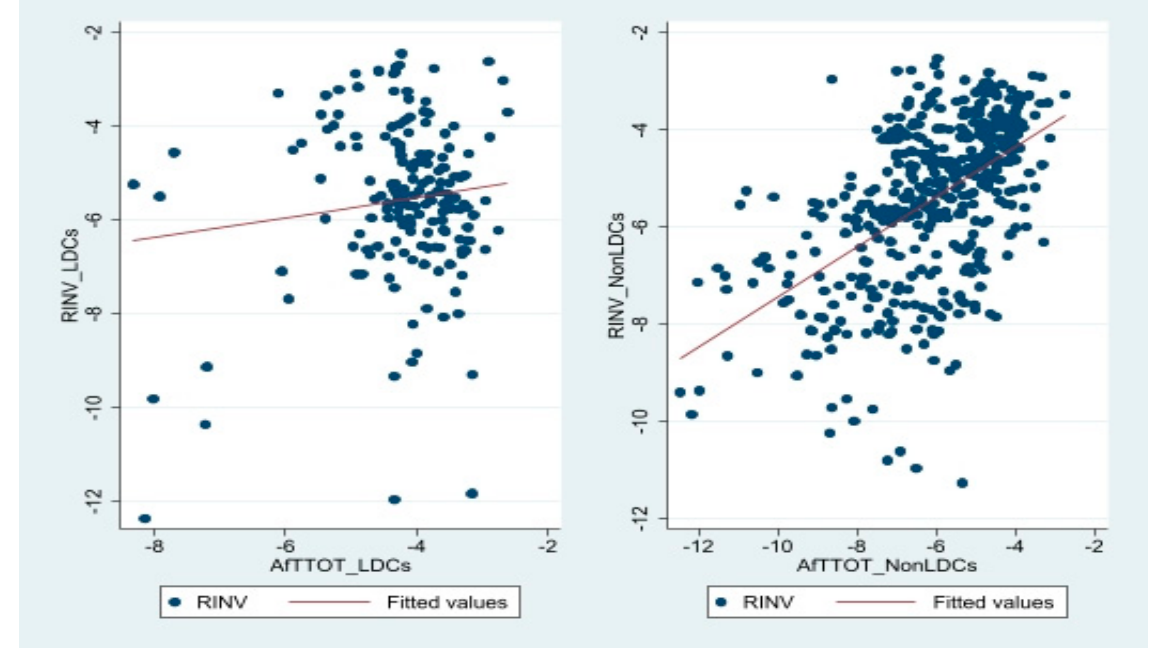
Figure 4. Correlation patterns between AfT flows and investment-oriented remittance flows over the subsamples of LDCs and non-LDCs. Source: Author. Note: The variable “RINV” is the natural logarithm of the share of remittance-oriented investment in GDP (not expressed in percentage). The variable “AfTTOT” is the natural logarithm of the share of total AfT flows in GDP (not expressed in percentage).